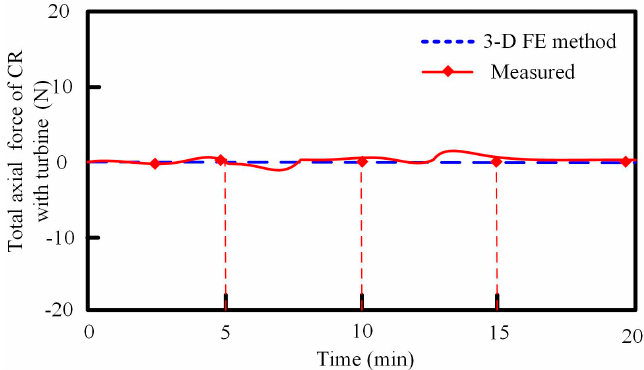
Figure 23. Comparison of the axial force resultant curves between simulated and experimental results.